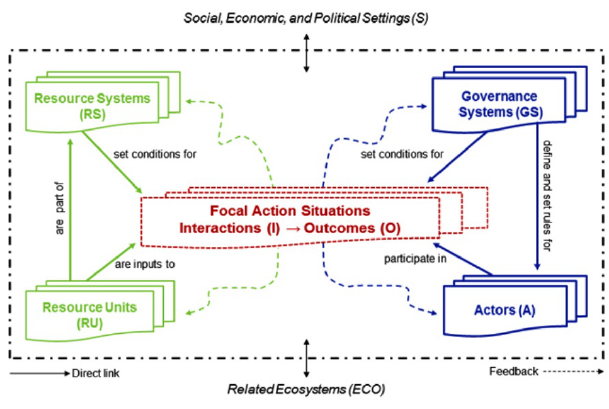
Fig. 1 . The first-tier variables of the social-ecological systems (SES) framework (McGinnis and Ostrom,